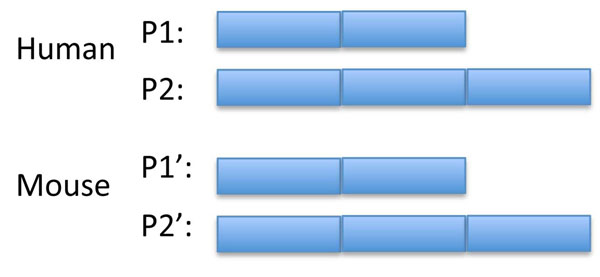
Illustration of the alternative transcript similarity scoring scheme. For an orthologue group with two alternative transcripts in each species, a global multiple sequence alignment results in the alignment of homologous exons. Where an alignment of isoforms that differ in the number of exons is used to calculate the similarity score (eg P1-P2') a score <1 will be obtained (0.67 in this case if the exons are assumed to have equal length) as the extra exon is matched by a gap in the alignment. P1-P1' and P2-P2' will give scores of 1.